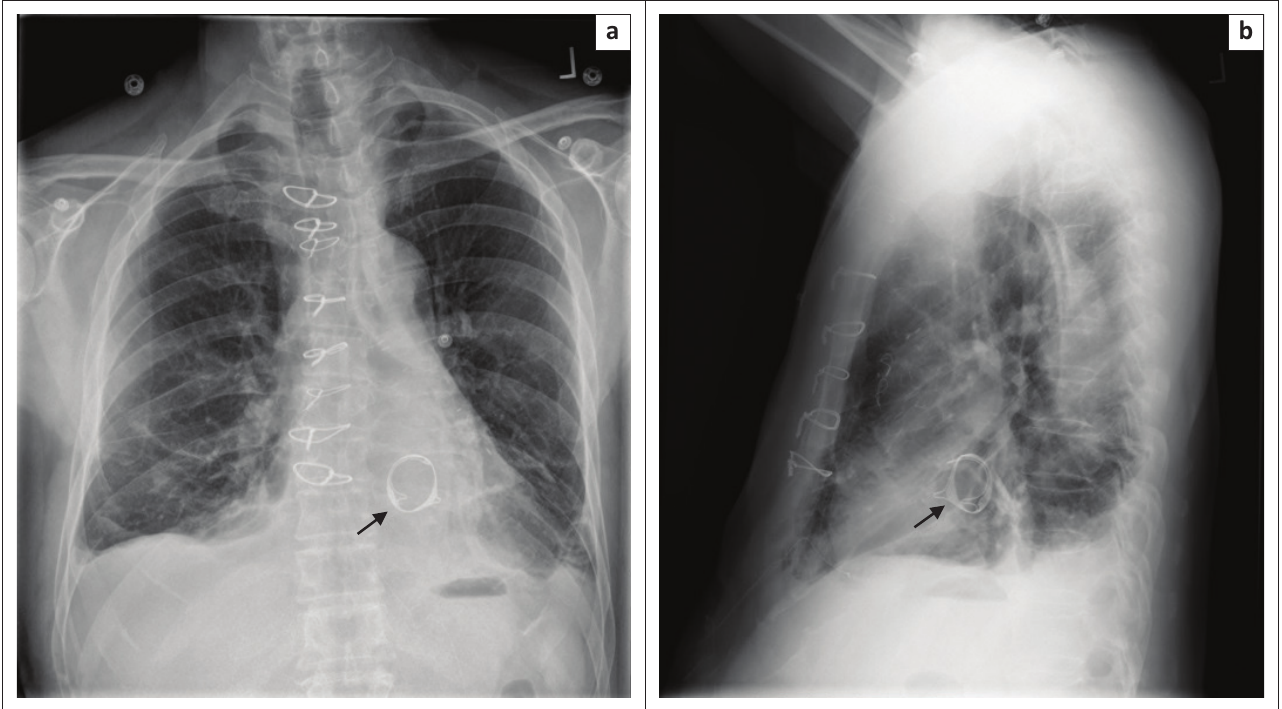
FIGURE 15: Frontal (a) and lateral (b) chest radiographs showing mitral (perimount tissue) valve replacement (arrow) in a patient with severe mitral